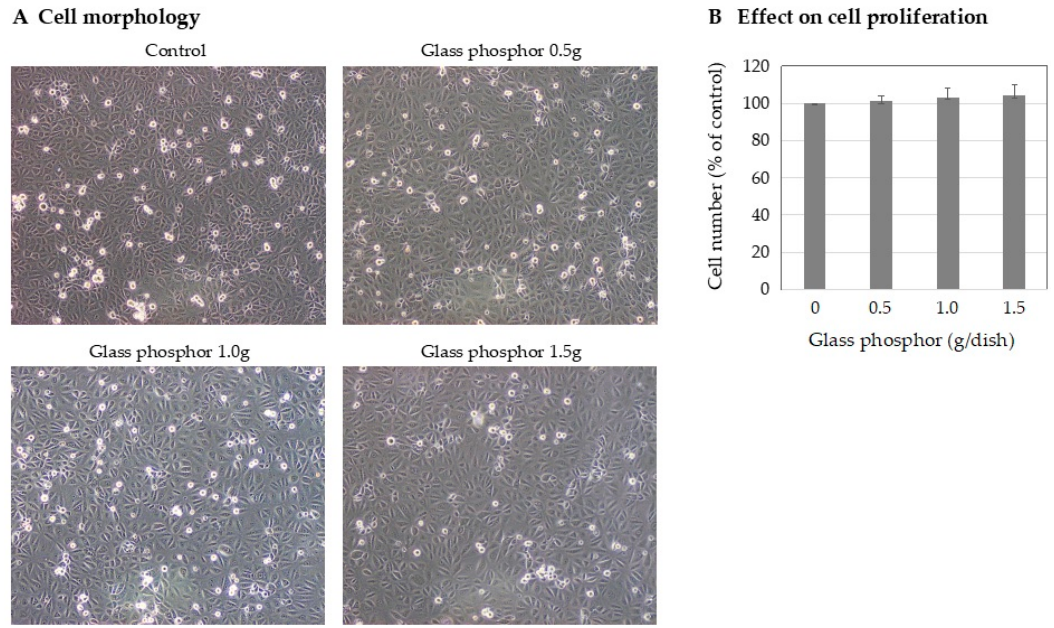
Figure 7. Effects of glass phosphor on the normal human mesothelial cells in culture. The cells were cultured in dishes containing glass phosphor (weights: 0.5, 1.0, and 1.5 g) for 72 h. ( A ) No significant change in the cell morphology was observed. ( B ) There was statistically no significant difference (NS) in the cell proliferation (by t -test). Bar = standard deviation.